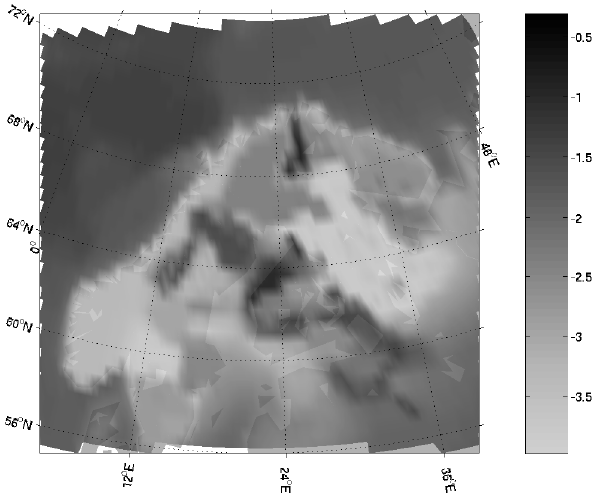
Fig. 3. Log 10 of the average taken over the Fennoscandian crustal (0–60km) conductivity [S/m] model used in the volume-3-D induc- tion code.